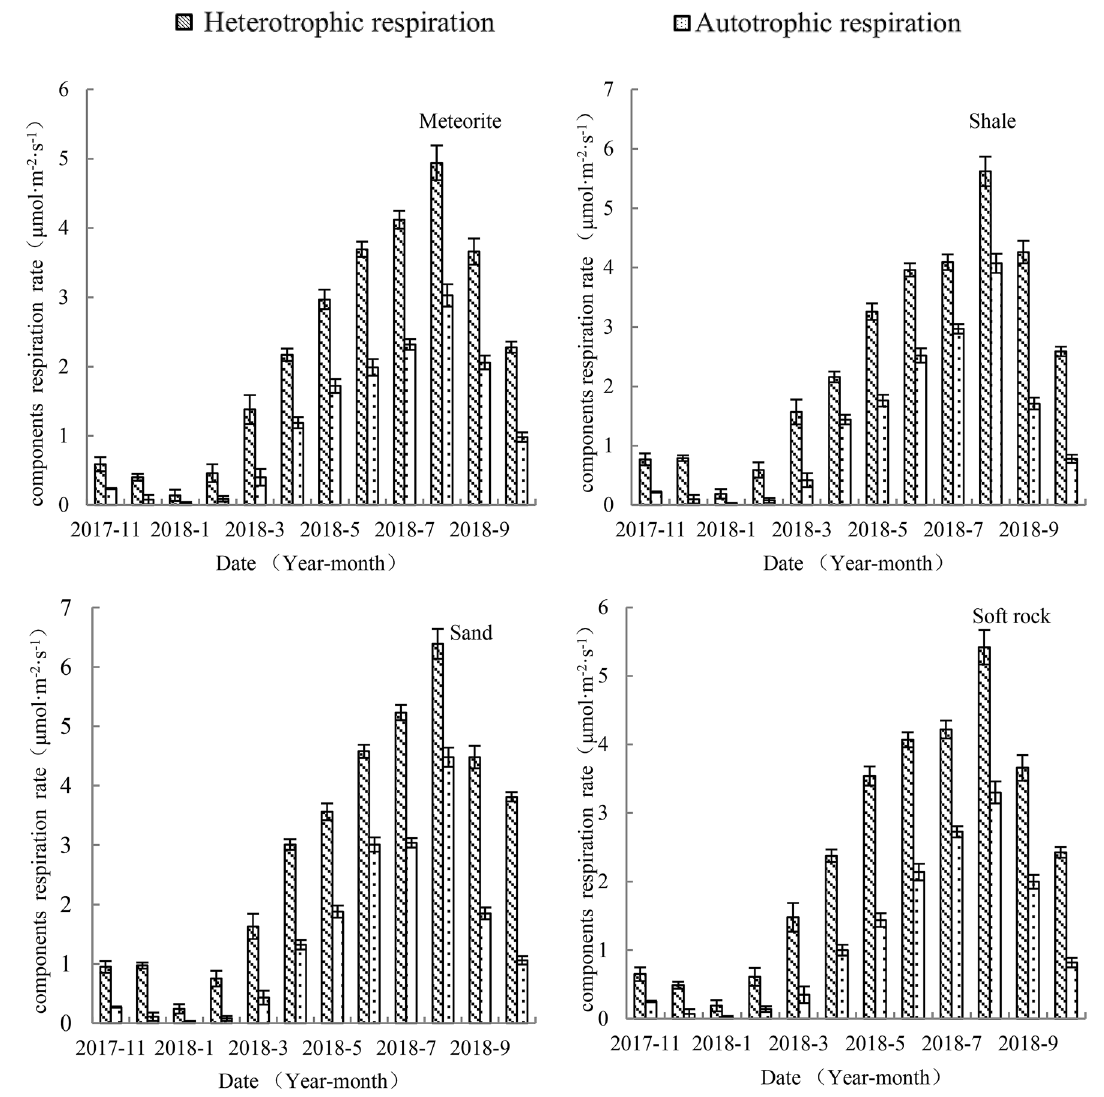
Figure 2. Components respiration rate of for different reconstructed